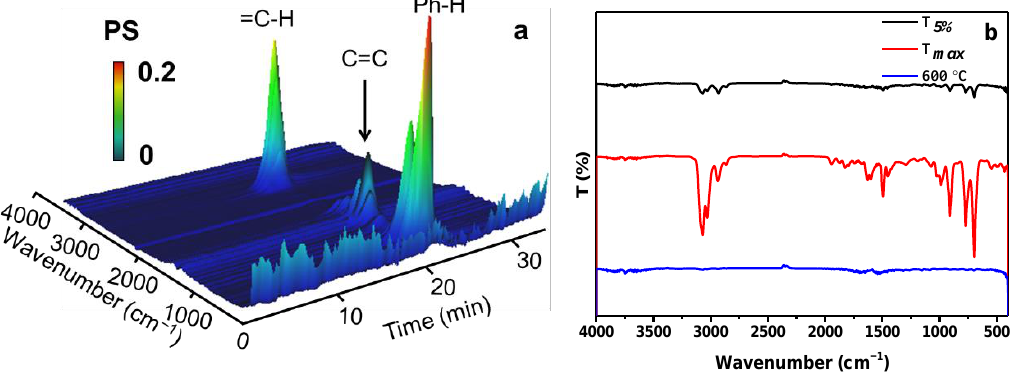
Figure 11. FTIR 3D map of evolved products at various times ( a ) and typical FTIR spectra at different temperatures ( b ) during the thermal degradation of PS.